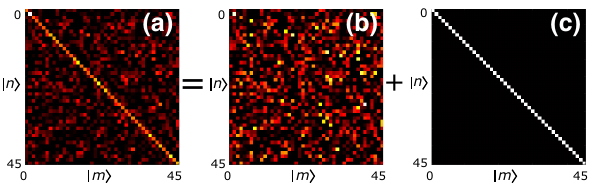
FIG. 11. The simulation of a correlation matrix. In the case of the maximally entangled state, a (a) correlation matrix is obtained by adding a (b) 45 × 45 matrix made of random values with mean parameter 0 and standard deviation σ = 1 / is the number of frames, to a (c) 45 × 45 diagonal matrix with diagonal values α . In this example, N = 10 6 and α = 1 / 45.